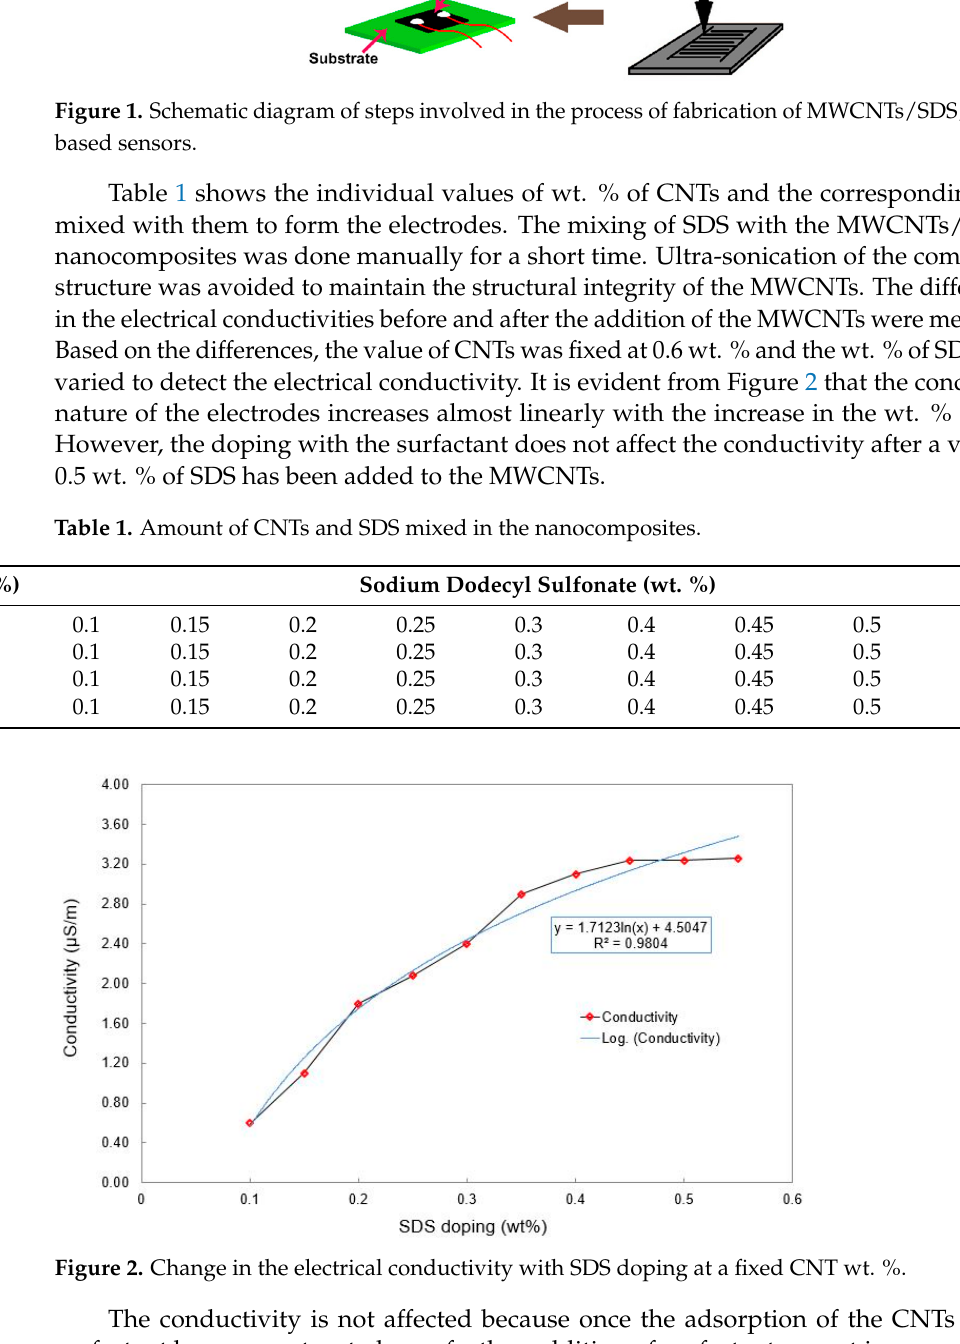
( b ) Figure 3. SEM images of the MWCNTs/SDS/PDMS composites at magnifications of ( a ) 1000× and ( b ) 2000×. The white and black colours represent the presence of surfactants and MWCNTs, respec- tively.